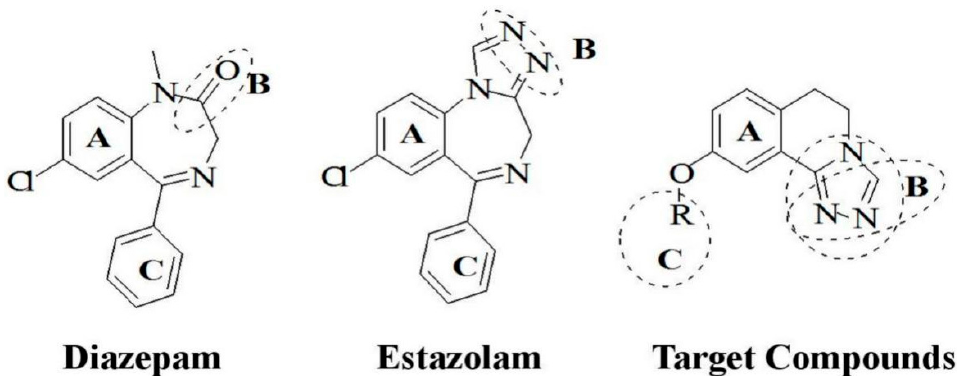
Figure 2. The structures of diazepam, estazolam, and the target compounds. (The dotted line was used to mark the special group).